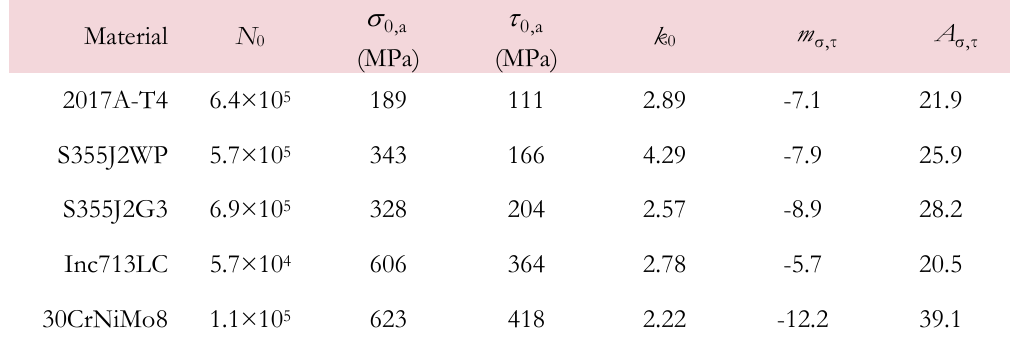
Table 2: Parameters related to the middle-curve criterion.